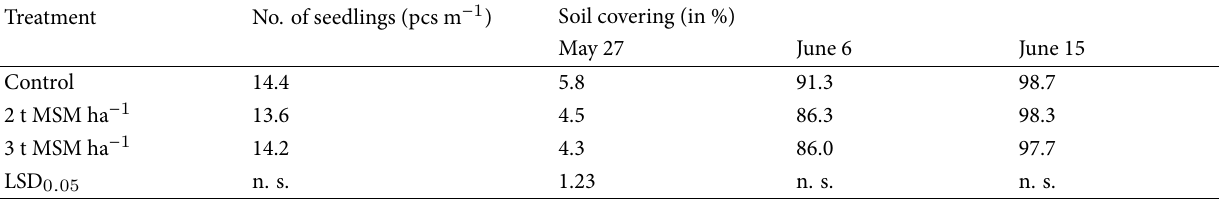
Table 1 Number of borage seedlings and soil covering by borage plants in May and June. Tr eatment No. of seedlings (pcs m − 1 ) Soil covering (in %)